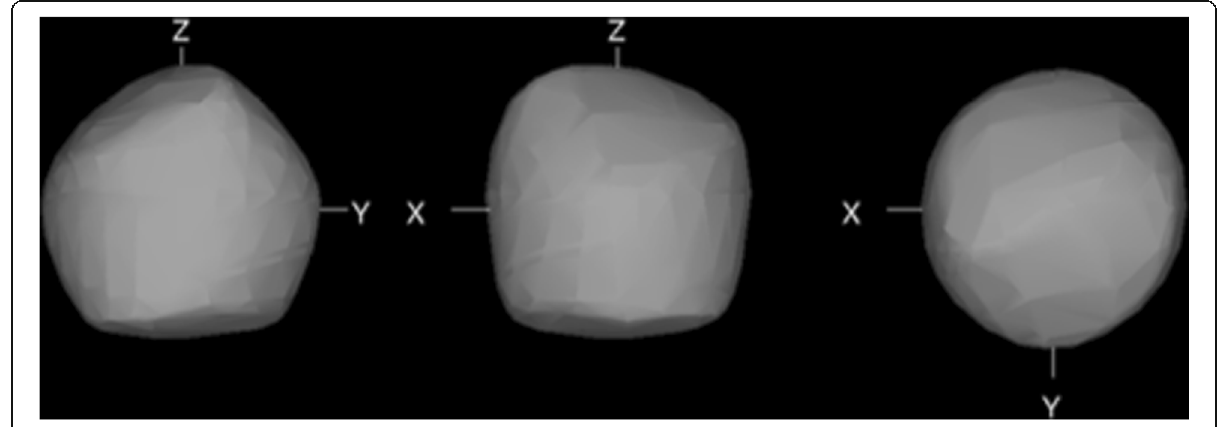
Fig. 1 Best fit shape model for Ryugu. Image taken from Müller et al. 2017